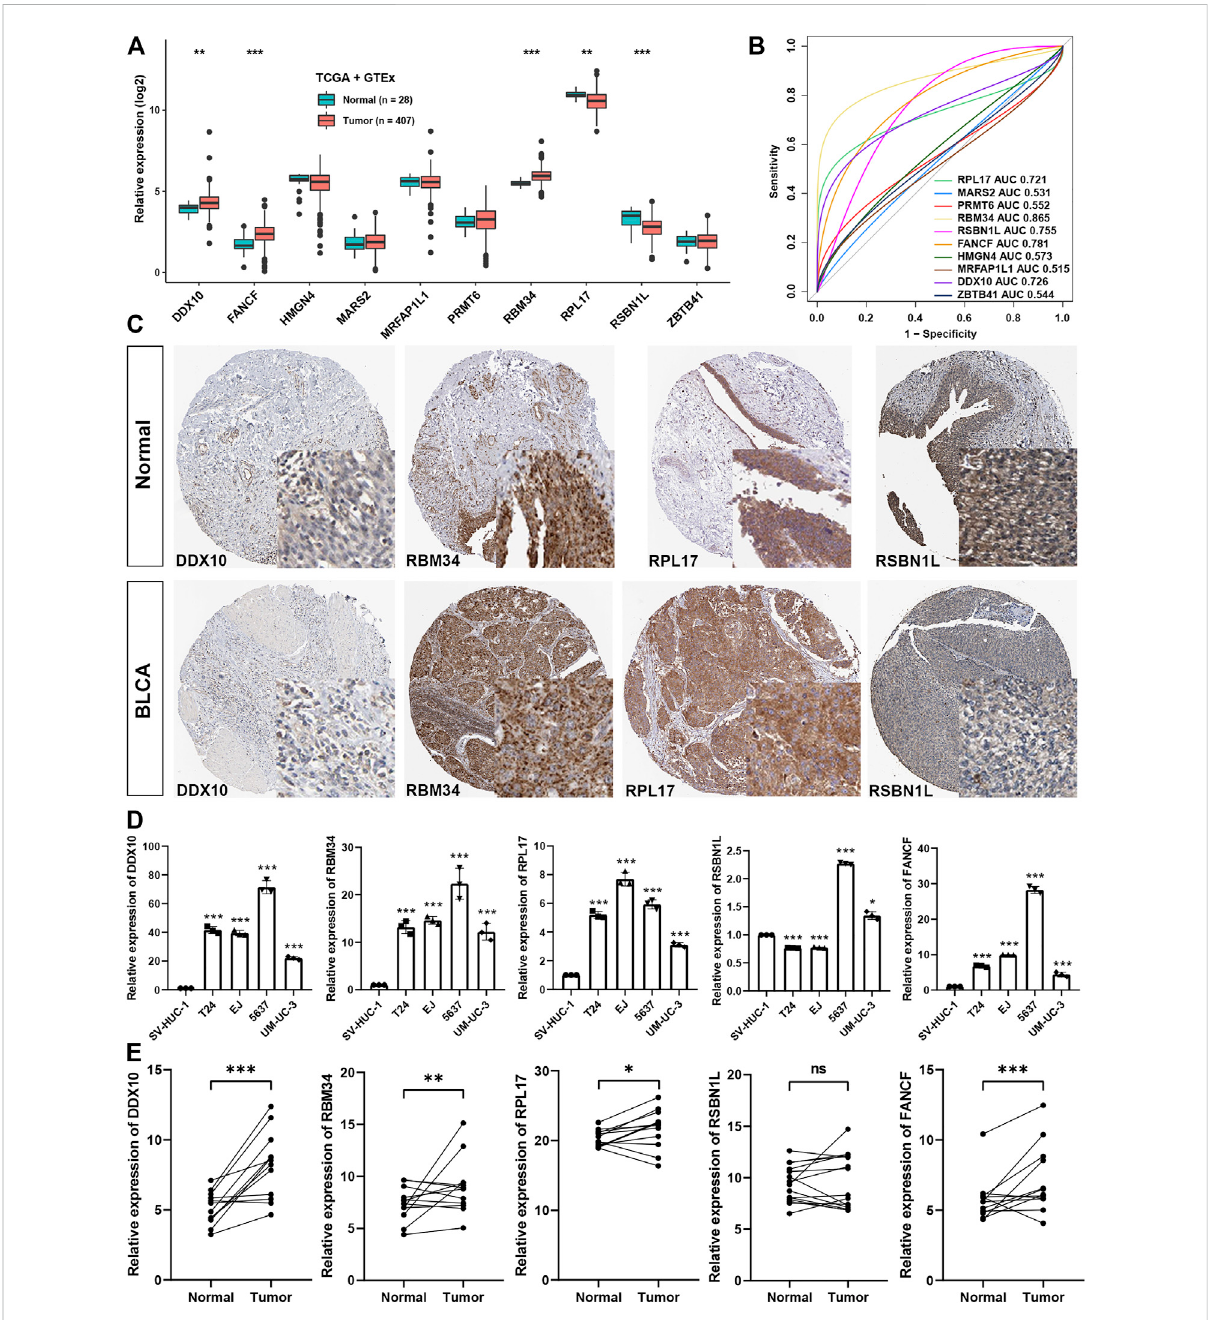
FIGURE 9 Thevalidationoftheexpressionofthegenesofthesignature (A) .TheexpressionlevelsofgenesinvolvedinCRscoresignaturebetweennormal and BLCA tissues in GTEx and TCGA datasets (B) . AUC for ten CR score signature members between tumor and normal tissues in GTEx and TCGA datasets (C) . Representative image of four members involved in CR signature in HPA dataset (D) . Experimental veri fi cation of the expression levels of the genes of the signature between normal cell line and BLCA cell lines through qRT-PCR (E) . Experimental veri fi cation of the expression levels of the genes of the signature between normal and BLCA tissues through